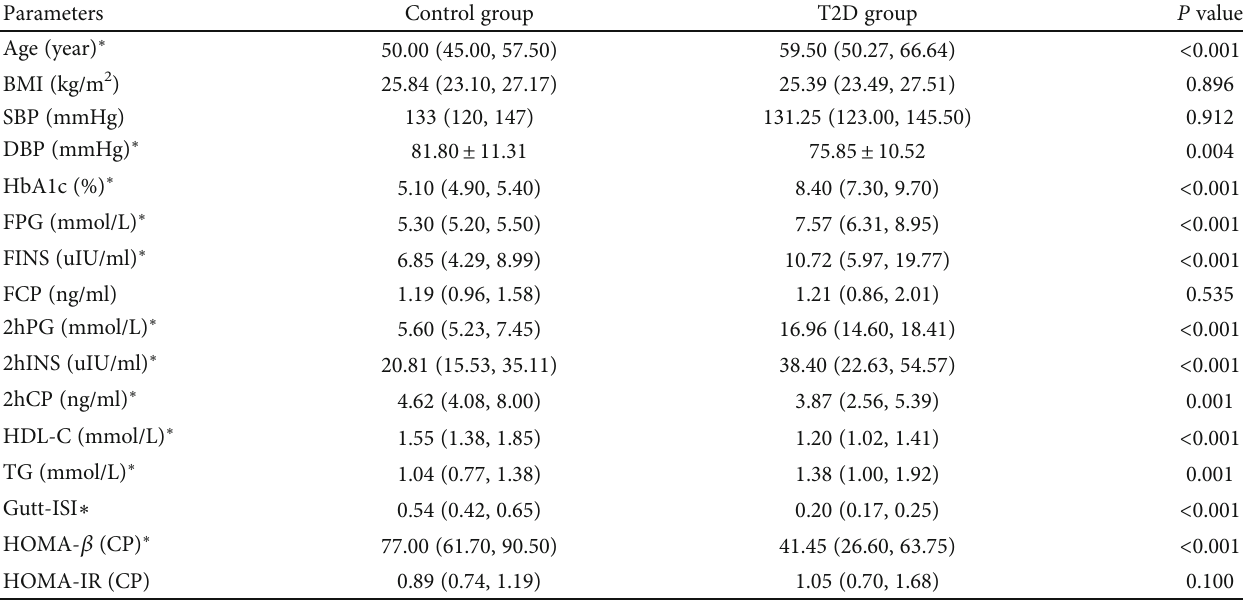
Table 1: Characteristics of T2D and control